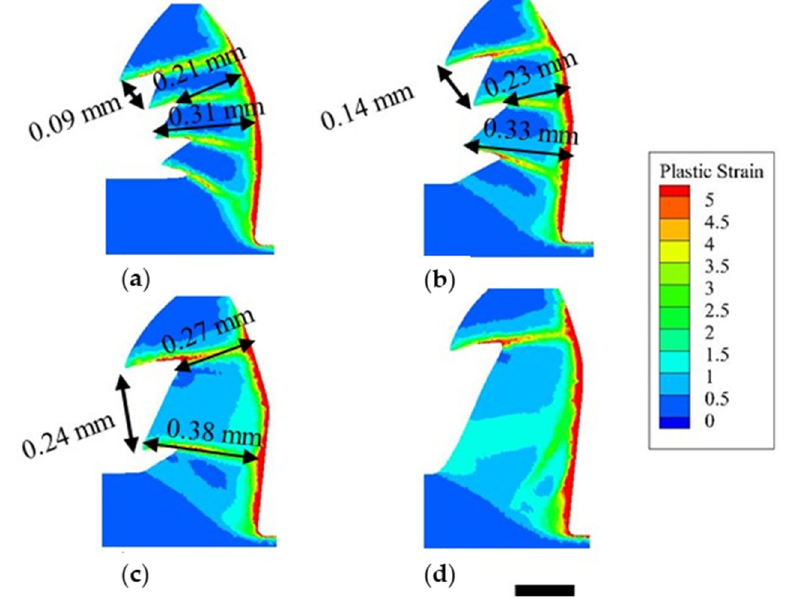
Figure 17. Variation of chip segmentation by varying the ε f,0 parameter: ( a ) ε f,0 = 0.25; ( b ) ε f,0 = 0.35; ( c ) ε f,0 = 0.45 and ( d ) ε f,0 = 0.5. Cutting conditions: V c = 7.5 m/min and f = 0.2 mm. Scale bar: 0.2 mm. ( c ) ε f ,0 = 0.45 and ( d ) ε f ,0 = 0.5. Cutting conditions: V c = 7.5 m/min and f = 0.2 mm. Scale bar: 0.2